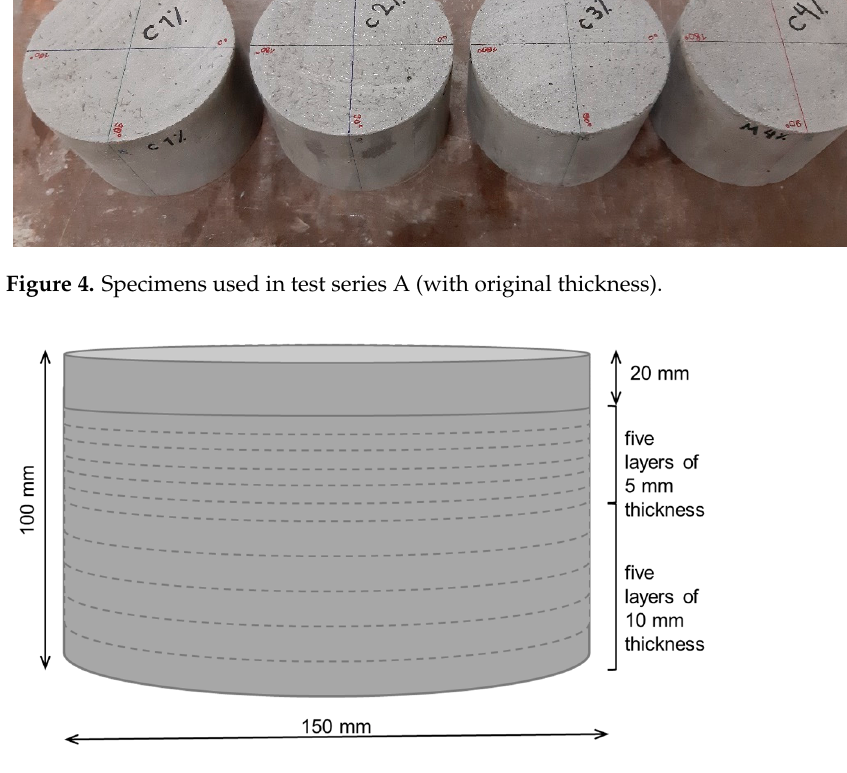
Figure 4. Specimens used in test series A (with original thickness).